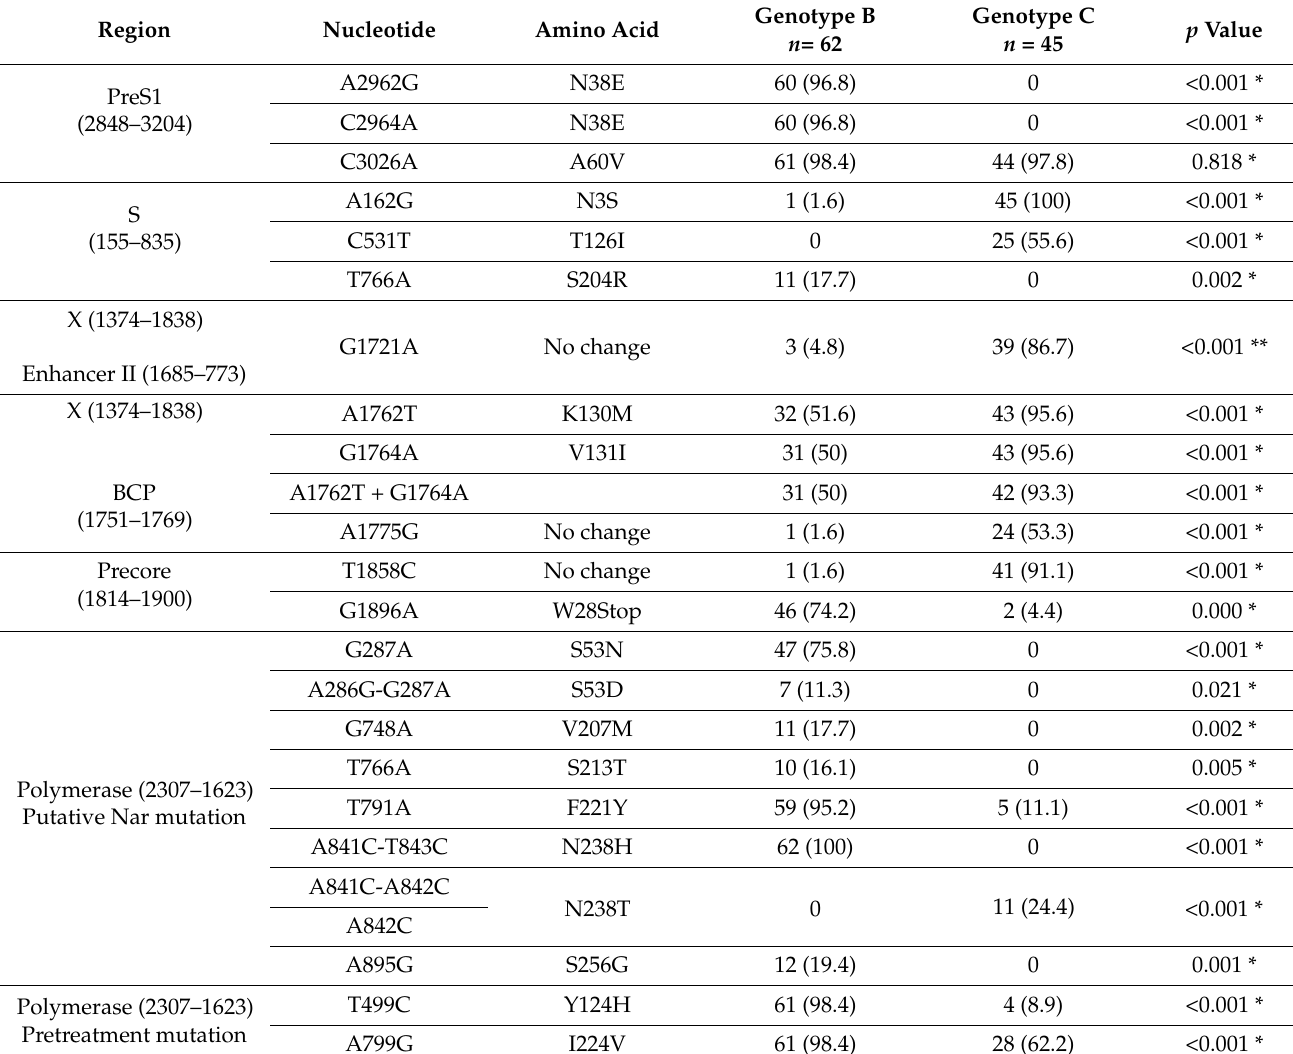
Table 3. Summary of HBV